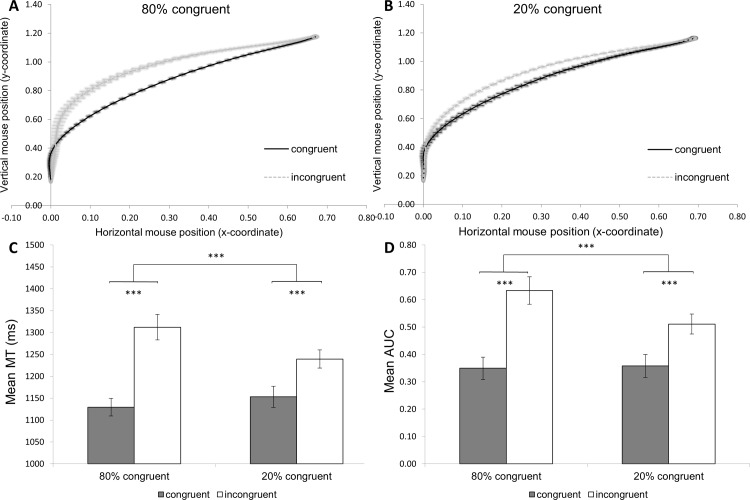
Panel A and B: Mean mouse trajectories for the congruent and incongruent trials as a function of proportion congruency (80% congruent: Panel A; 20% congruent: panel B).Error bars represent 95% confidence intervals. Panel C and D: Mean MT and AUC for the congruent and incongruent trials as a function of proportion congruency (i.e., ISPC effect). Error bars represent standard errors. ***p<.001.